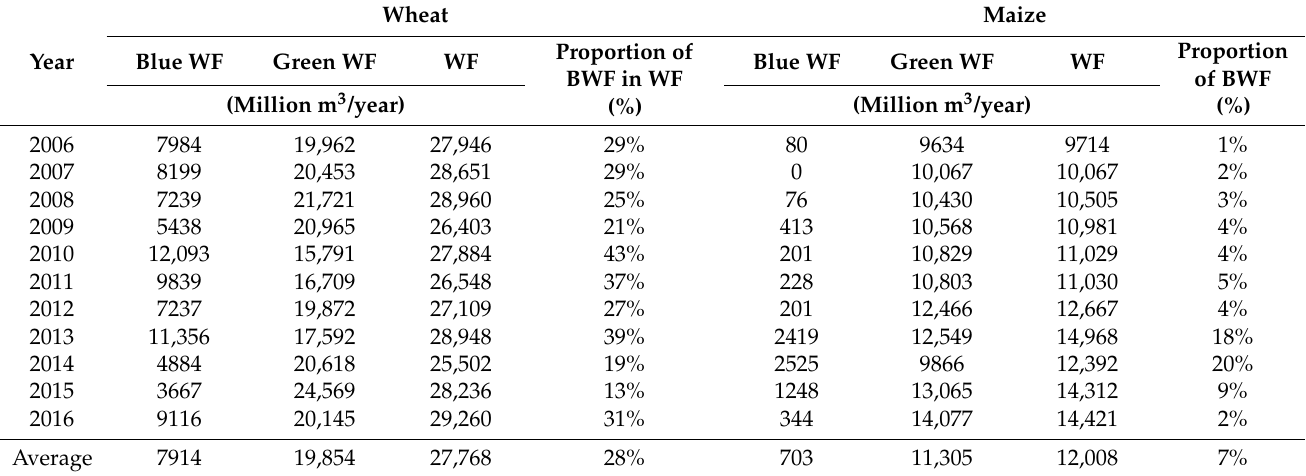
29,260 Average We averaged the WF (m 3 /t) of wheat/maize production for each city in Henan Province from 2006 to 2016, and showed their spatial distribution in Figure 2. The BWF (m 3 /t) of wheat was higher in western and northern Henan, but lower in southern Henan. The highest was found in San Menxia (583 m 3 /t), followed by Zhengzhou (544 m 3 /t) and Luoyang (524 m 3 /t), and the lowest was found in Zhoukou (33 m 3 /t), Zhu Madian (34 m 3 /t), and Xinyang (94 m 3 /t). The WF (m 3 /t) of wheat was higher in central Henan, western Henan, and southern Henan, but lower in eastern Henan. The highest values were found in San Menxia (1400 m 3 /t), Luoyang (1349 m 3 /t), and Zhengzhou (1280 m 3 /t), while the lowest values were found in Zhoukou (586 m 3 /t) and Shangqiu (724 m 3 /t). The blue WF of maize was higher In western and central Henan, but lower in eastern Ping Dingshan (105 m 3 /t), Shangqiu, and Zhu Madian was 0. In the central, western,